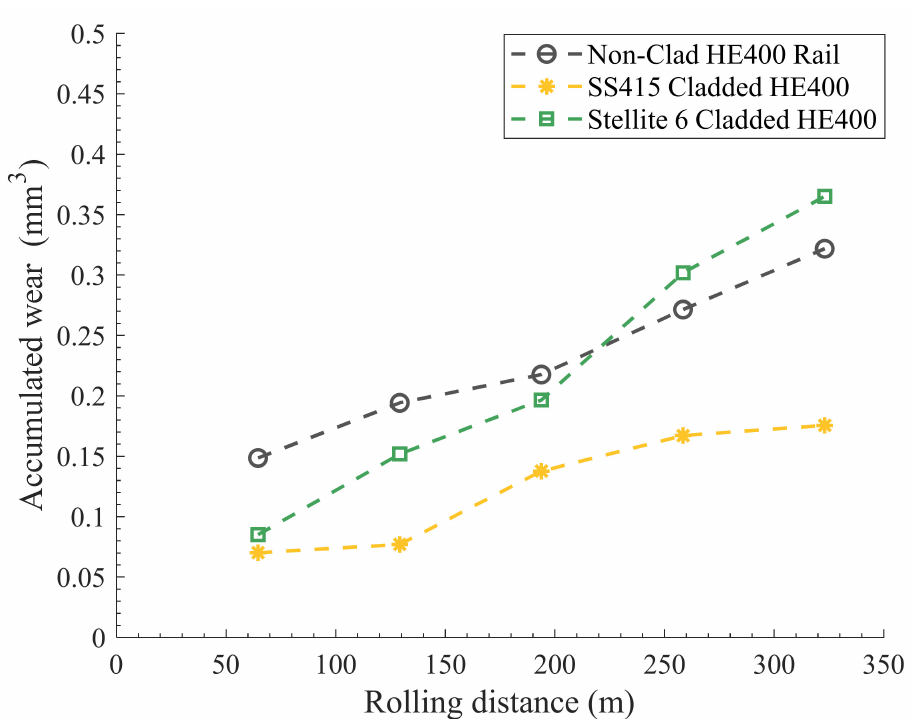
Figure 7. The accumulated wear performance of the non-clad and cladded hypereutectoid rails [10,12].